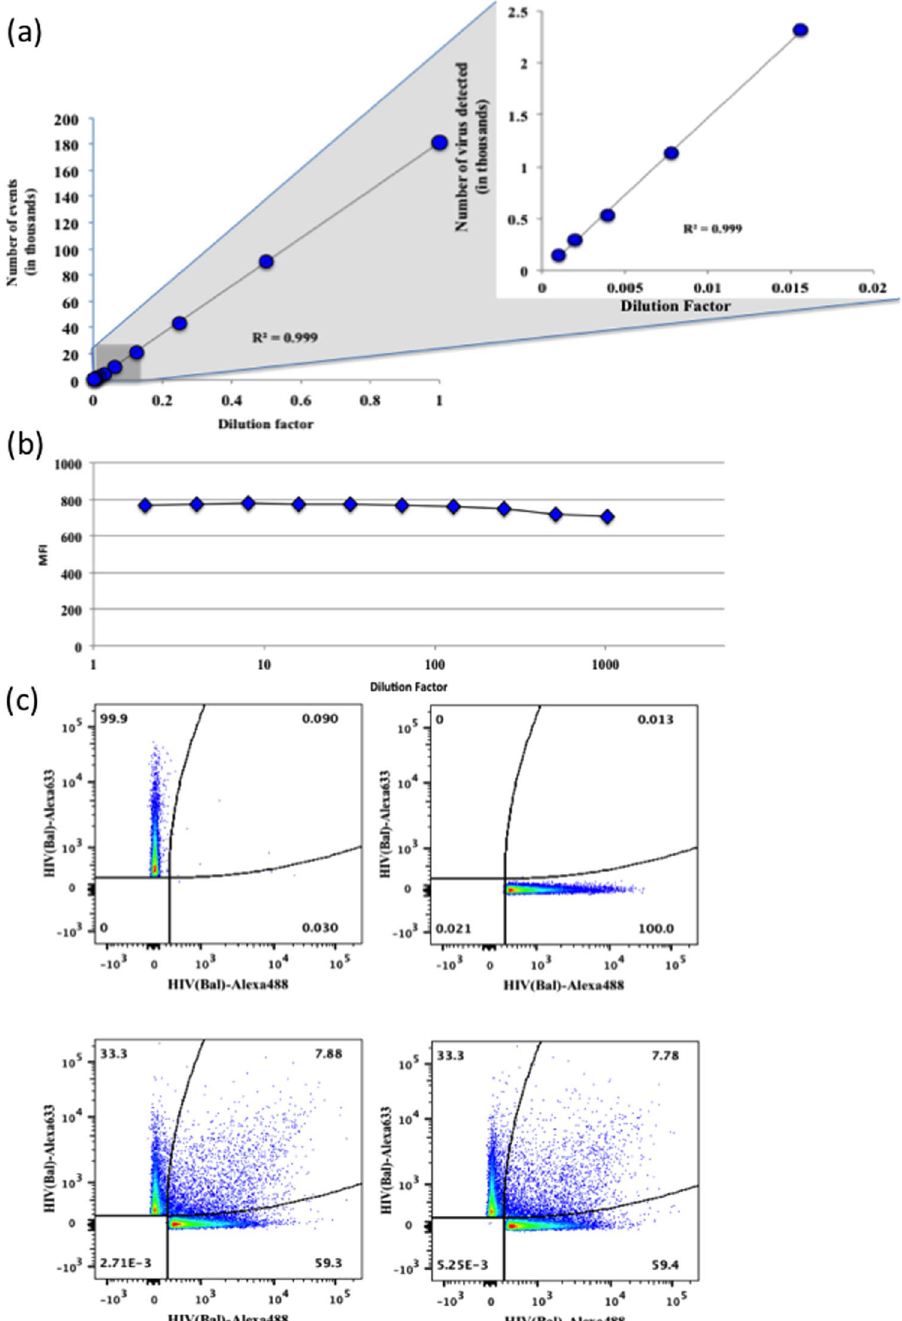
Figure 1. Analysis of individual HIV virions. HIV BaL labeled with Alexa Fluor 488 5C Maleimide was captured with 2G12-MNPs, isolated on magnetic column and serially diluted from 2 to 2 10 fold. The events were acquired in a fixed volume of 80 μ l in duplicate using a High Throughput Sampler (HTS) at a flow rate of 0.5 μ l per second on the LSRII flow cytometer, set to be triggered by Alexa Fluor 488 fluorescence. ( a ) Presented are numbers of events as a function of the dilution factor. Right panel is blow up of points near 0. ( b ) Median fluorescence intensity (MFI) of two-fold serially diluted events. ( c ) HIV BaL preparation was split into two fractions; one fraction was labeled with Alexa Fluor 633 5C Maleimide (upper left panel) the other fraction was labeled with Alexa Fluor 488 5C Maleimide (upper right panel). The two differently labeled HIV fractions were mixed (lower left panel) and all the fractions were captured with 2G12-MNPs and isolated on magnetic columns. Alternatively, mixed fraction after capture with 2G12-MNPs was incubated with detection antibodies (lower right panel). The resultant complexes were eluted from the columns and analyzed on flow cytometer triggered on